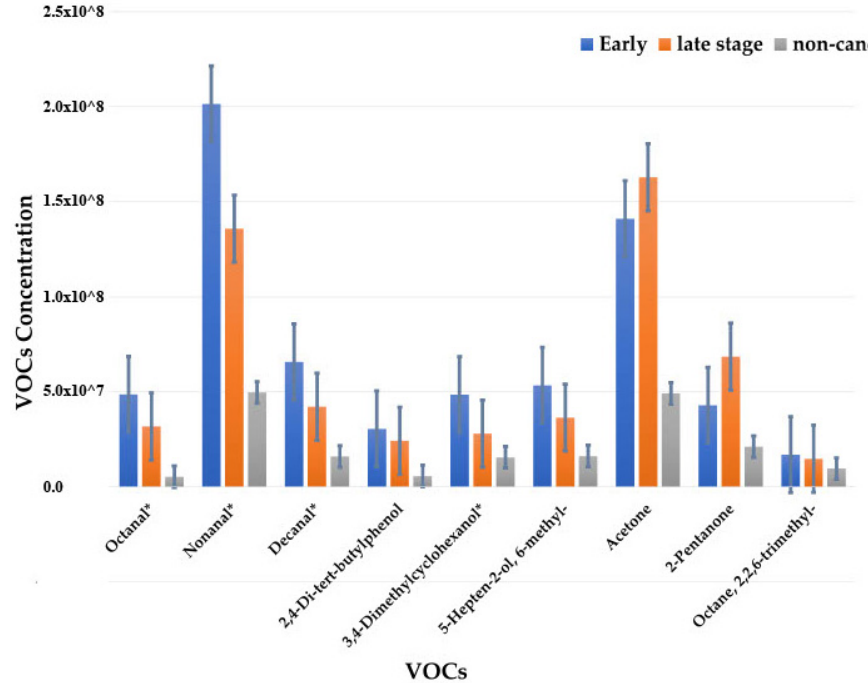
Figure 10. Bar graph for the VOCs present in the study with their respective average concentration among early-stage CRC, late-stage CRC, and non-cancer samples. The * mark represents statistically significant VOCs.